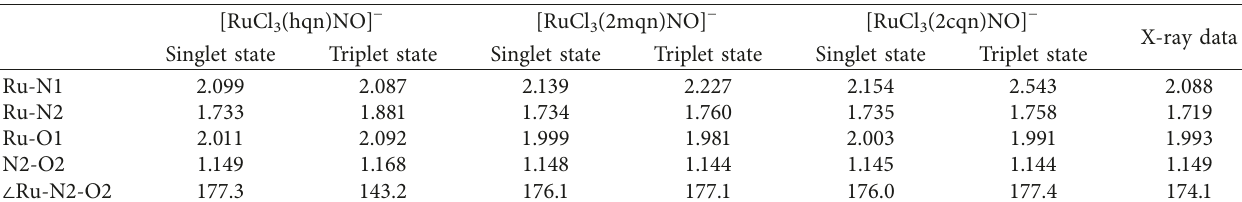
Figure 1: Optimized structures of [RuCl Table 1: Optimized ν s. experimental geometries (in ˚ A and ° ) with 6-311++G(d,p) and Aug-cc-pVDZ-PP as basis set.